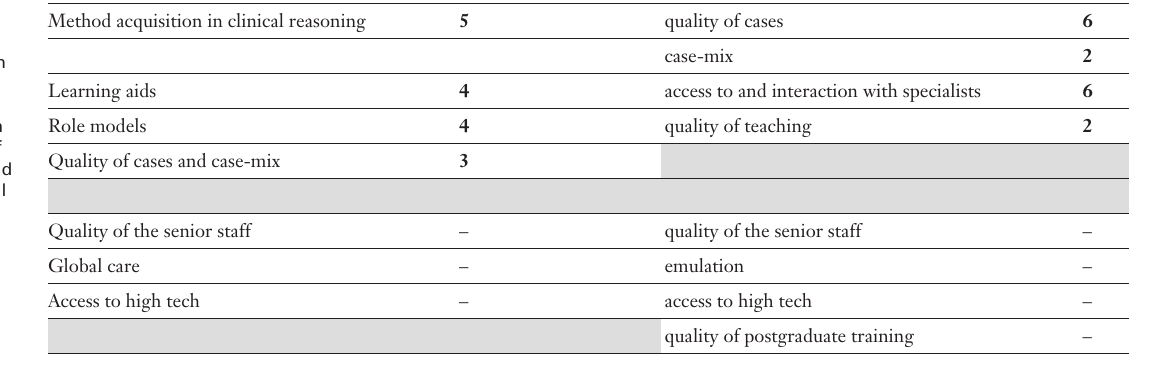
The assets of a Uni- versity service of Internal Medicine in the training of the future general inter- nist, and comparison of their priority scores as judged by the present staff of a University service of Internal Medicine and by practising general internists.